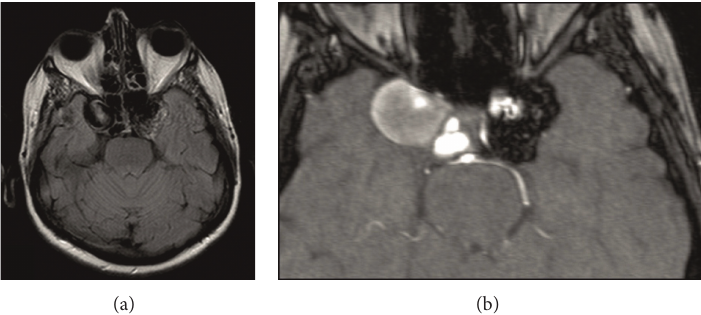
Figure 2: T 1 weighted MRl axial slices of the same patient 2 days after treatment of the left intracavernous carotid artery aneurysm with endovascular coil embolization (a). Note the slight hypointensity due to thrombosis in the region of the previous left aneurysm